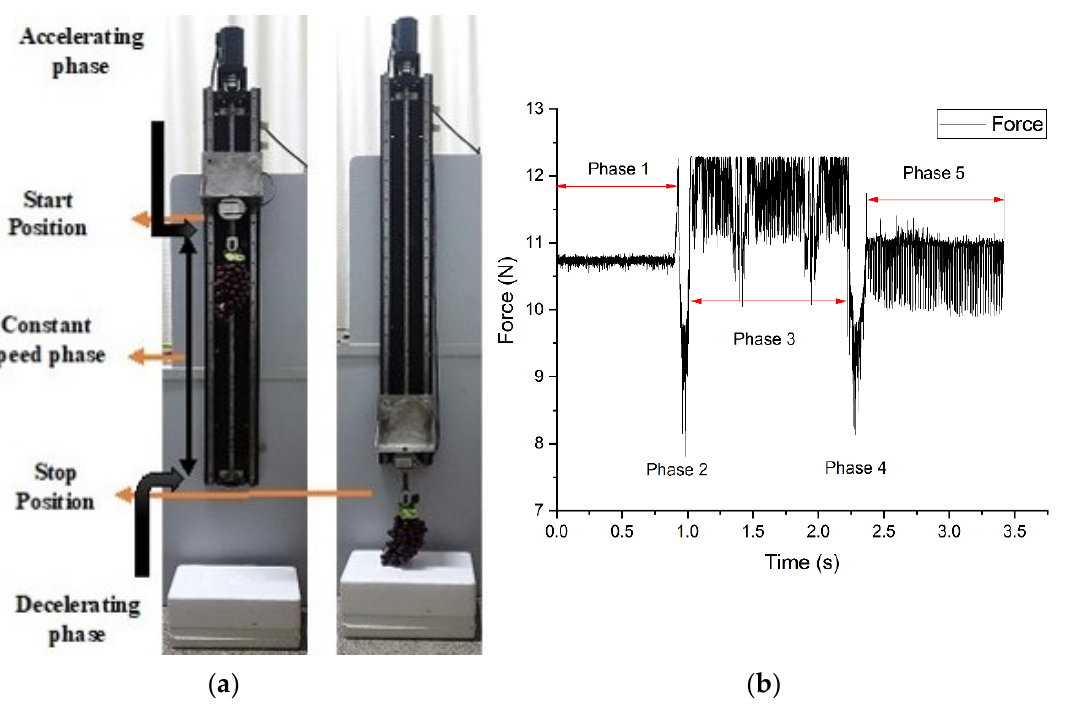
Figure 5. Vibration characteristics of the grape cluster during vertical transportation: ( a ) phases of the grape cluster; ( b ) force signals.